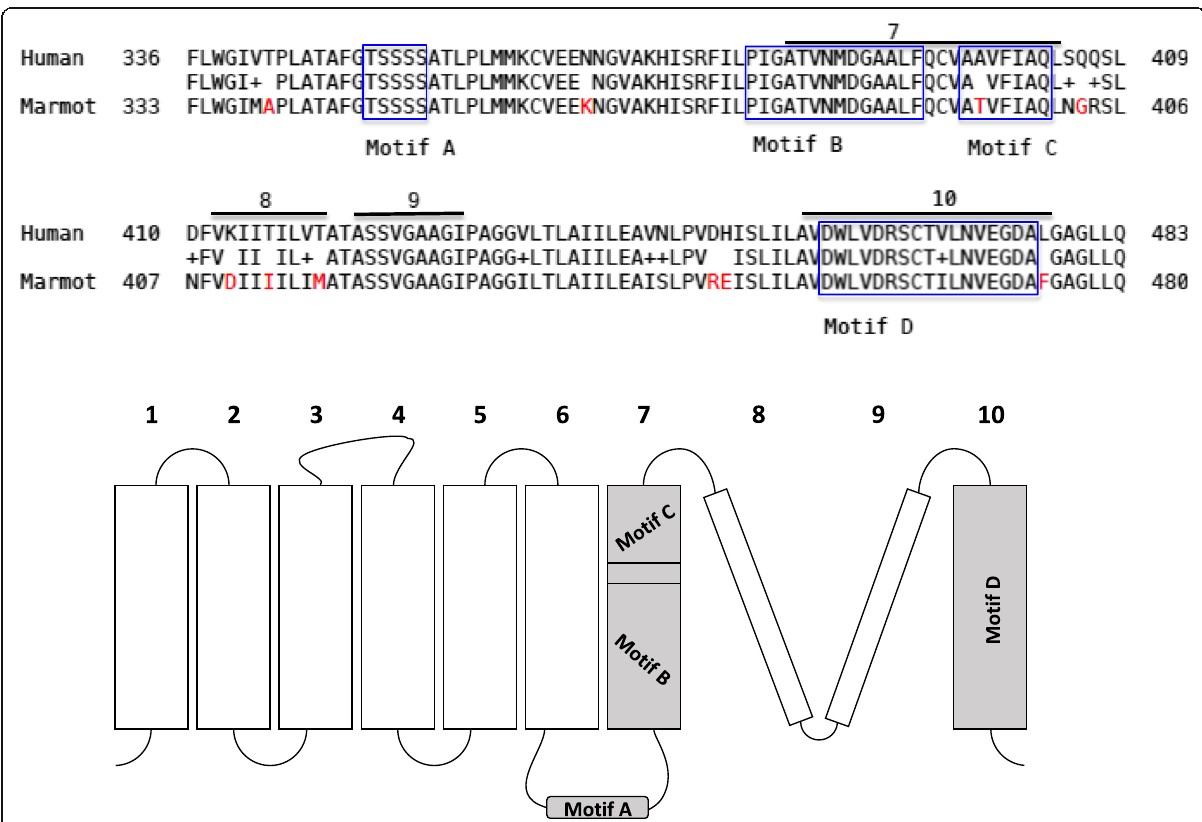
Fig. 4 Top: BLAST of protein sequence between human and woodchuck (marmot) ASCT2. The upper bars highlight the trans-membrane segments, and the blue boxed are the key motifs involved in amino acid transport. The red letters represent the differences between the two species in amino acid residues. Bottom: membrane model of ASCT2 towards the C-terminal. While segments 7 and 10 are helices, 8 and 9 form a re-entrant loop-pore structure with conserved motifs (A, B, C, and D), adapted from Ref.